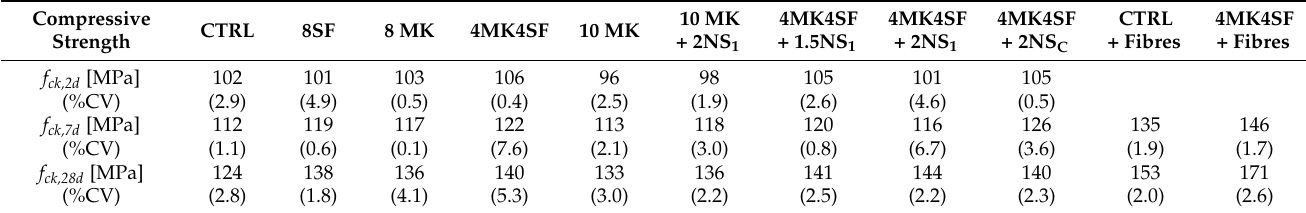
Table 4. Compressive strength values of UHPC studied at different